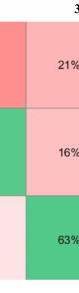
Figure 6. Identification results when IMFs were not